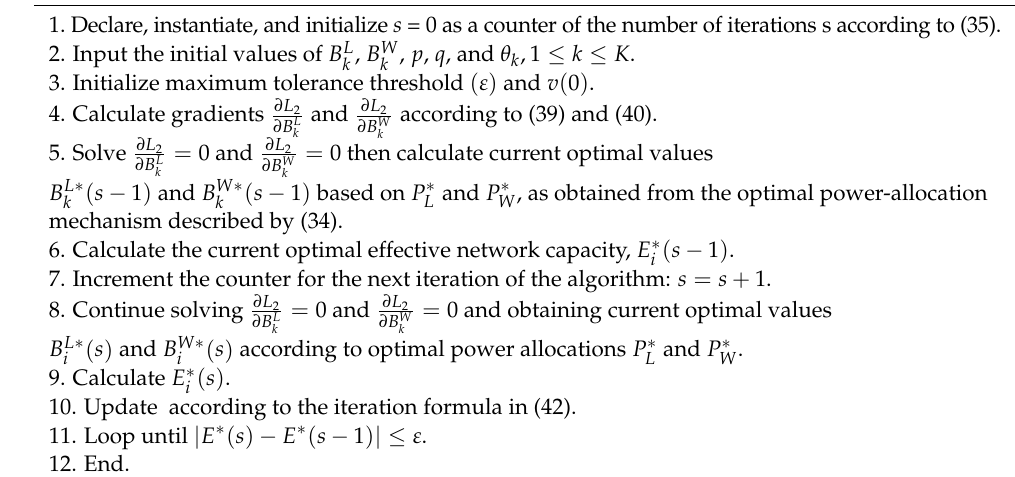
Algorithm 1. Optimal bandwidth allocation using the sub-gradient